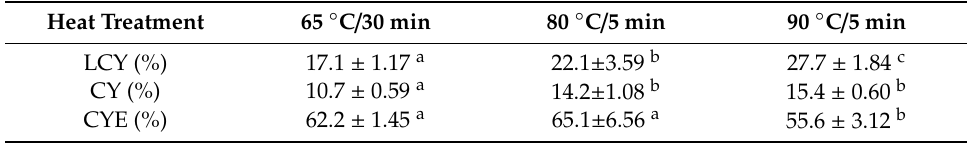
Table 1. Laboratory yield (LCY), yield (CY) and yield e ffi ciency (CYE) of curd made from caprine